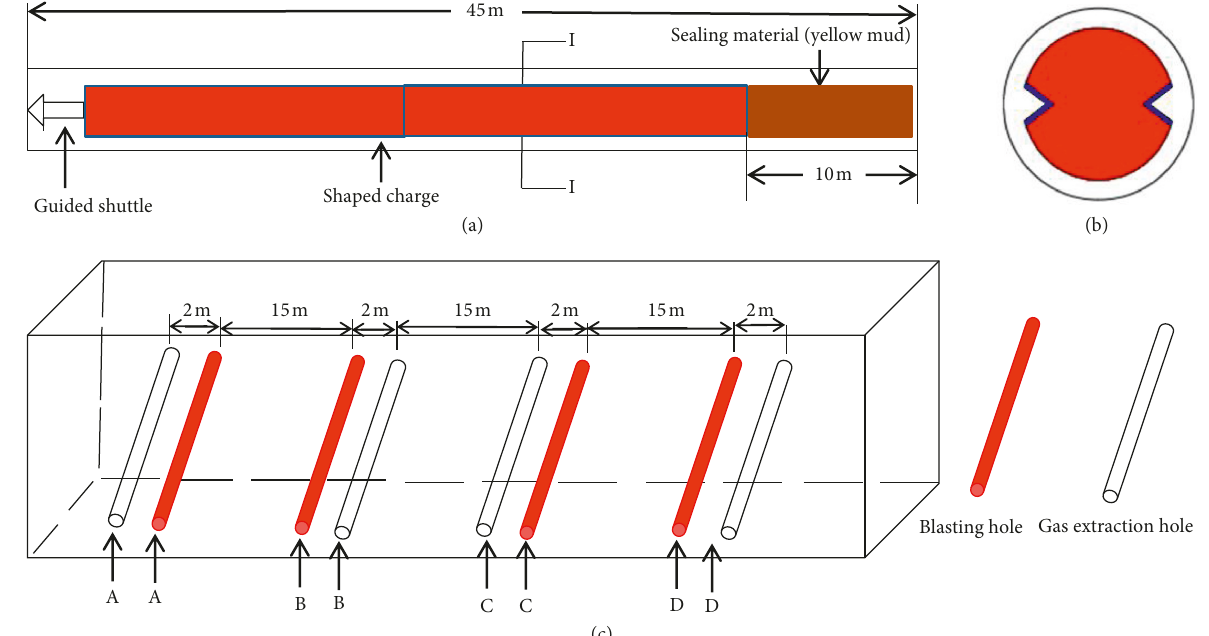
Figure 11: Structure of cumulative blasting and sketch of boreholes in the investigated area. (a) Structure of cumulative blasting in hole. (b) Profile of I-I. (c) Layout of blasting and gas extraction holes in field